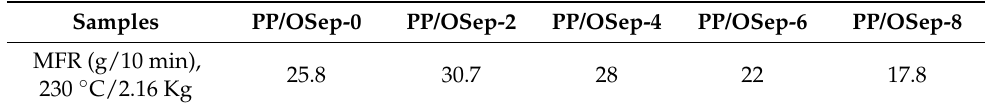
Table 2. Melting flow rate (MFR) of PP/OSep nanocomposites. Samples